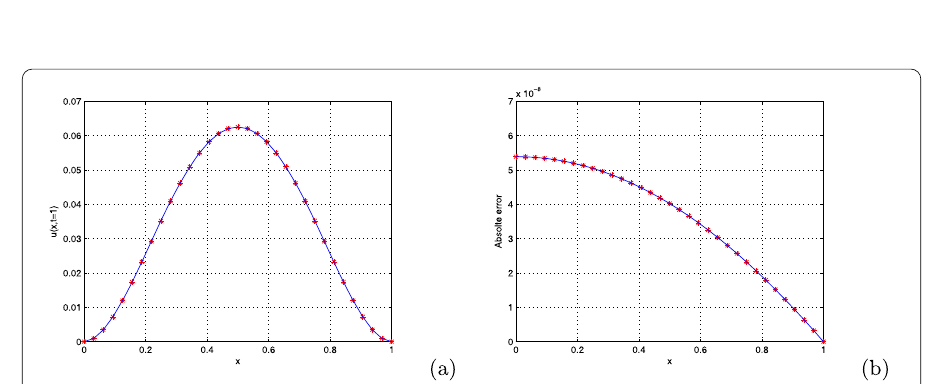
Figure 5 The comparison ( a ) and absolute error ( b ) between the numerical solution and the exact solution with α = 0.8 at t = 1 ( h = 1/32, τ =